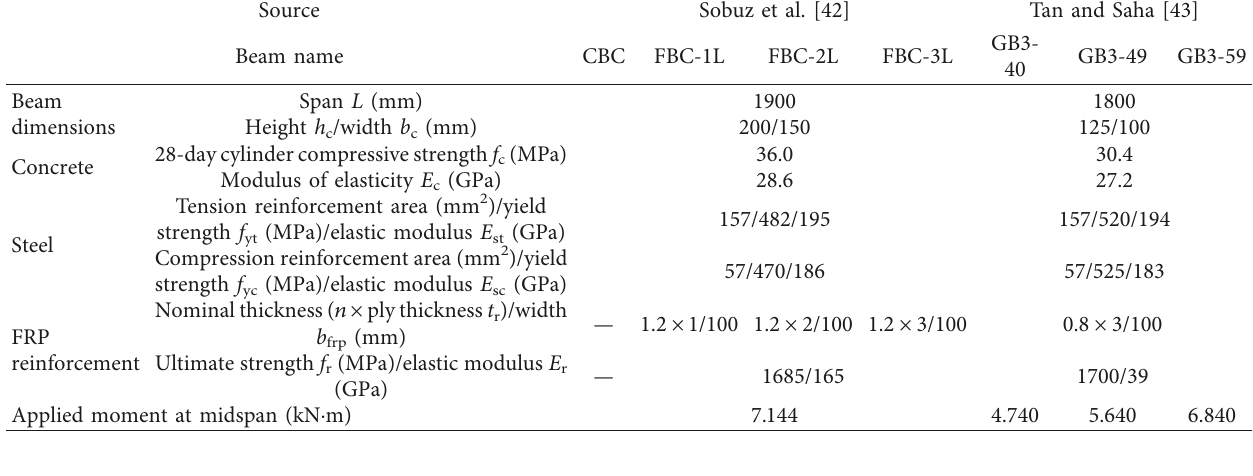
Table 5: Properties of selected specimens for numerical simulation.